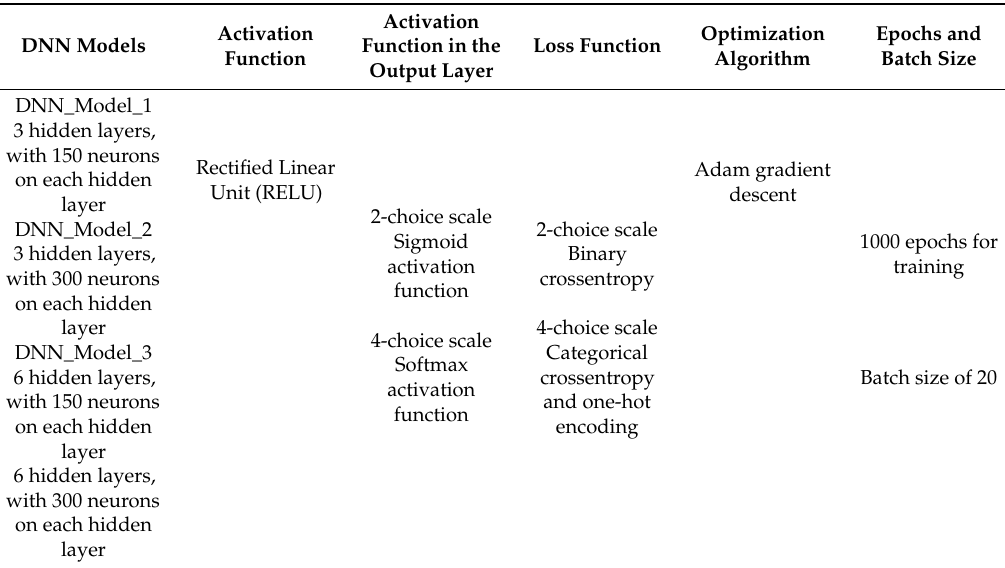
Table 3. Properties of the Deep Neural Network